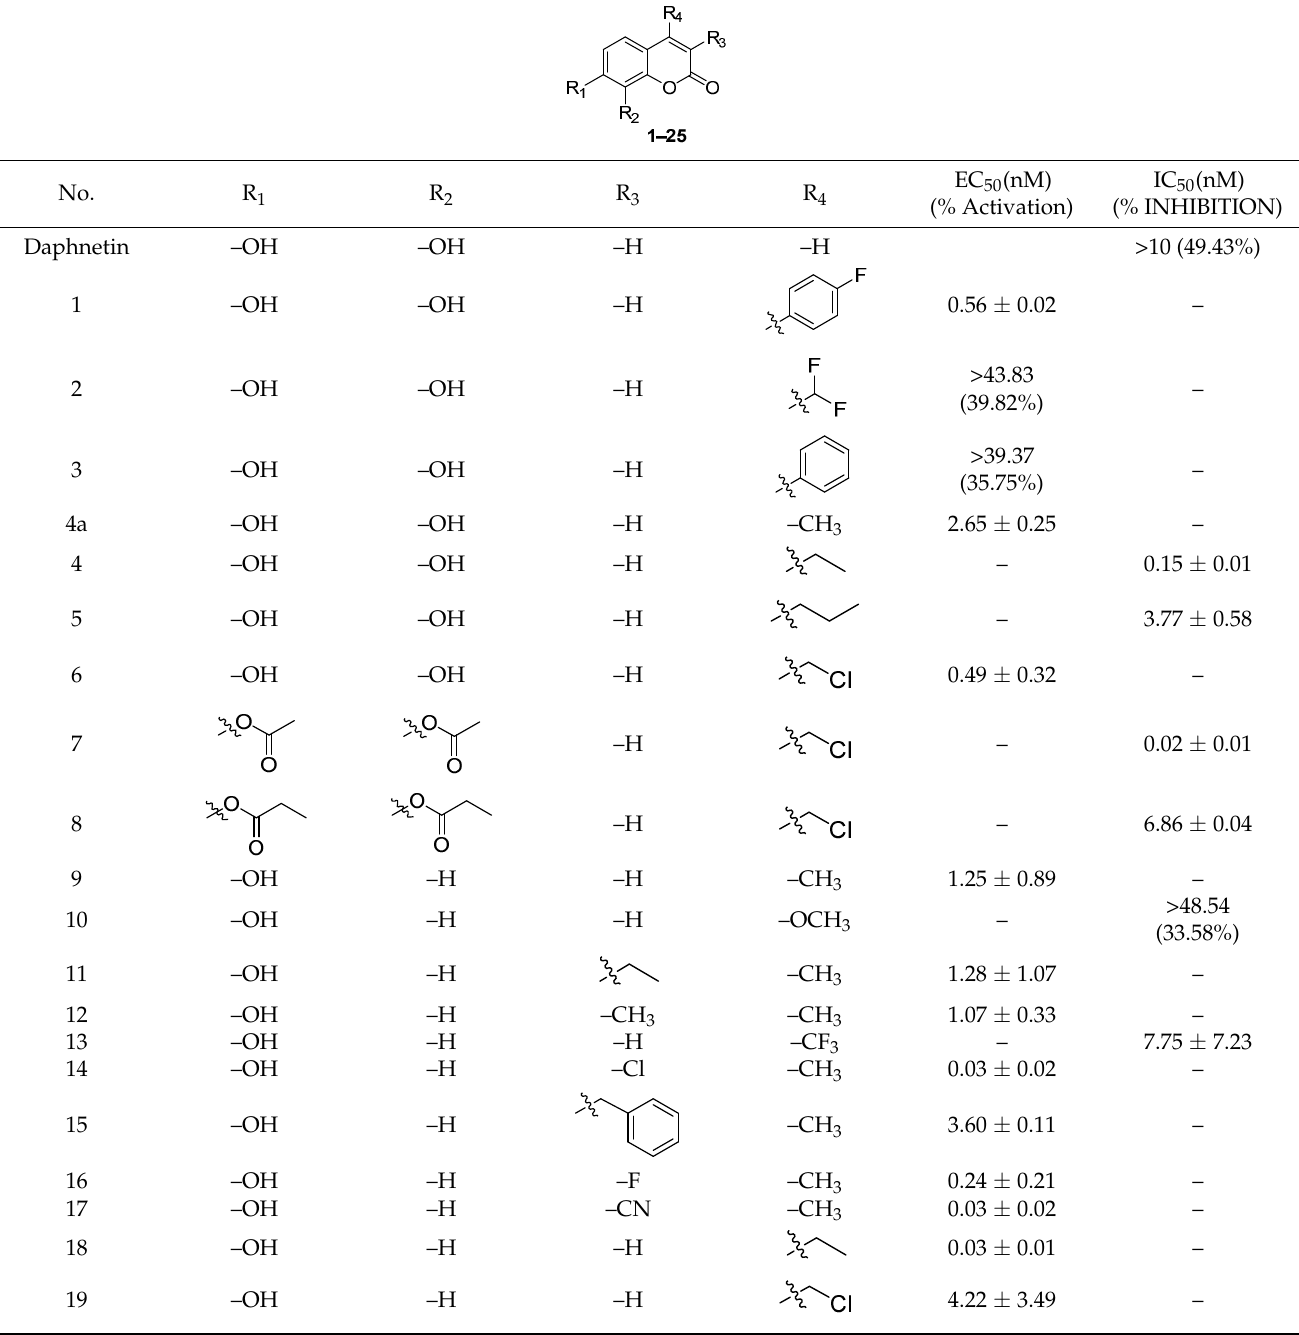
(EC 50 = 3.60 nM) showed a decreasing activation potency, suggesting that the acylation of Table 1. In vitro GPCR inhibition IC 50 or activation EC 50 (nM) activities of daphnetin and the hydroxyl group at C-7 was not beneficial for activation activity. Table 1. In vitro GPCR inhibition IC 50 or activation EC 50 (nM) activities of daphnetin and derivatives Table 1. In vitro GPCR inhibition IC 50 or activation EC 50 (nM) activities of daphnetin and derivatives Table 1. In vitro GPCR inhibition IC Table 1. In vitro GPCR inhibition IC 50 or activation EC 50 (nM) activities of daphnetin and derivatives Table 1. In vitro GPCR inhibition IC 50 or activation EC 50 (nM) activities of daphnetin and derivatives Table 1. In vitro GPCR inhibition IC 50 or activation EC 50 (nM) activities of daphnetin and derivatives 50 or activation EC 50 (nM) activities of daphnetin and derivatives Table 1. In vitro GPCR inhibition IC 50 or activation EC 50 (nM) activities of daphnetin and derivatives Table 1. In vitro GPCR inhibition IC 50 or activation EC 50 (nM) activities of daphnetin and derivatives Table 1. Table 1. In vitro GPCR inhibition IC 50 or activation EC 50 (nM) activities of daphnetin and derivatives In vitro GPCR inhibition IC 50 or activation EC 50 (nM) activities of daphnetin and derivatives Table 1. In vitro GPCR inhibition IC Table 1. In vitro GPCR inhibition IC 50 or activation EC 50 (nM) activities of daphnetin and derivatives Table 1. In vitro GPCR inhibition IC 50 or activation EC 50 (nM) activities of daphnetin and derivatives 1 – 25. Table 1. In vitro GPCR inhibition IC 50 or activation EC 50 (nM) activities of daphnetin and derivatives 1 – 25. 1 – 25. Table 1. In vitro GPCR inhibition IC 50 or activation EC 50 (nM) activities of daphnetin and derivatives 1 – 25. 50 or activation EC 50 (nM) activities of daphnetin and derivatives Table 1. In vitro GPCR inhibition IC 50 or activation EC 50 (nM) activities of daphnetin and derivatives Table 1. In vitro GPCR inhibition IC 50 or activation EC 50 (nM) activities of daphnetin and derivatives 1 – 1 – 25. 1 – 25. 1 – 25. 1 – 25. 1 – 25. 1 – 25. 1 – 25.